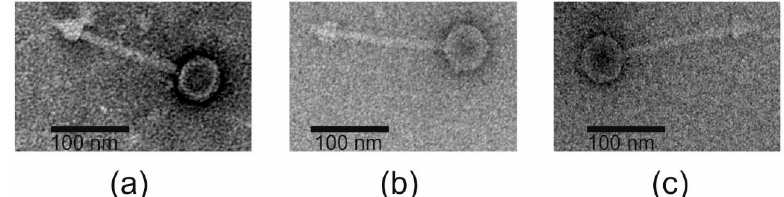
Figure 1. Transmission electron micrographs of fEg-Aba01 ( a ), fLi-Aba02 ( b ), and fLi-Aba03 ( c ). The phages were negatively stained with 2% uranyl-acetate. The scale bar is 100 nm.